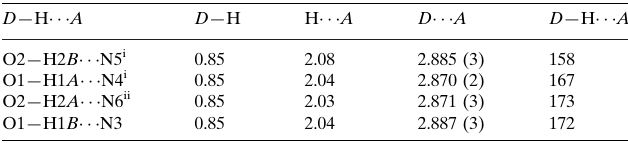
Hydrogen-bond geometry (A˚ , (cid:3)